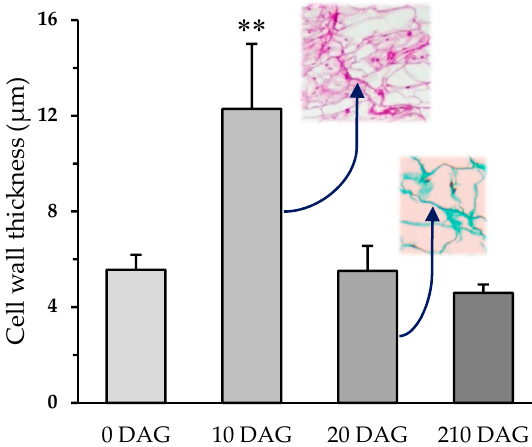
Figure 2. Cell wall thickness ( μ m) of pith cells in the adhesion line of homografts at different days after grafting (DAG). Average and standard deviation are represented (N = 80). Student t test was performed between 0 DAG vs. 10, 20, and 210 DAG; ** p < 0.01.